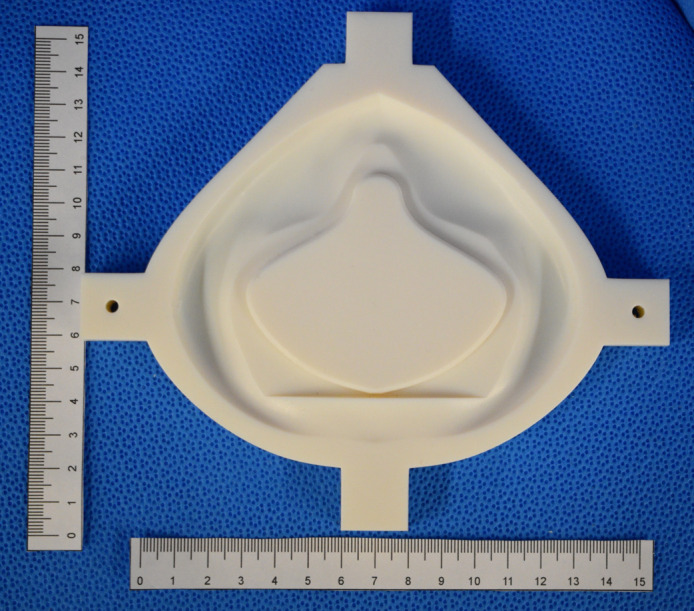
3D printed mold base is shown.